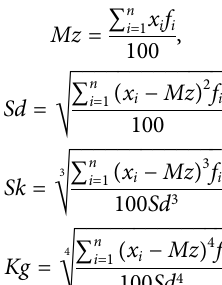
( Figure 1 ) is located in the Xingang Development Zone on south bank of the Yangtze River, approximately 20 km northeast of Nanjing City, Jiangsu Province. The XG pro fi le is a typical Xiashu loess pro fi le exposed by engineering excavation. The pro fi le is about 15.7 m in thickness, with interbedded loess and paleosol ( Table 1 ), and has three steps dividing the pro fi le into three distinct sections: from bottom to top, these are XG-1, XG-2 and XG-3, respectively. The complete pro fi le has four paleosol layers and three loess layers ( Table 1 ). A weathering crust and Cretaceous sandstone are visible in the lower part. A total of 81 samples were collected from bottom to top at equal intervals of 20 cm for grain-size analysis and quartz grain surface microtextural and morphological observations.